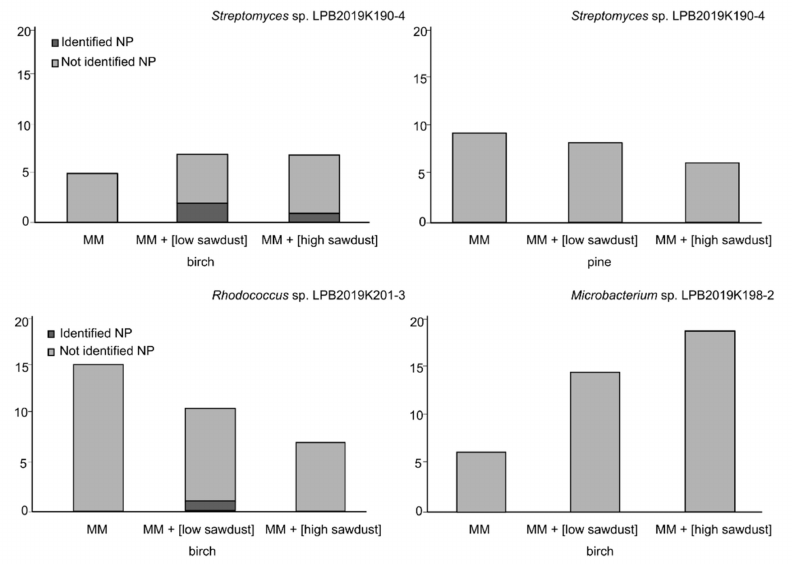
Figure 4. Number of natural products produced by the studied Actinobacteria when cultivated on nutrient media with sawdust.